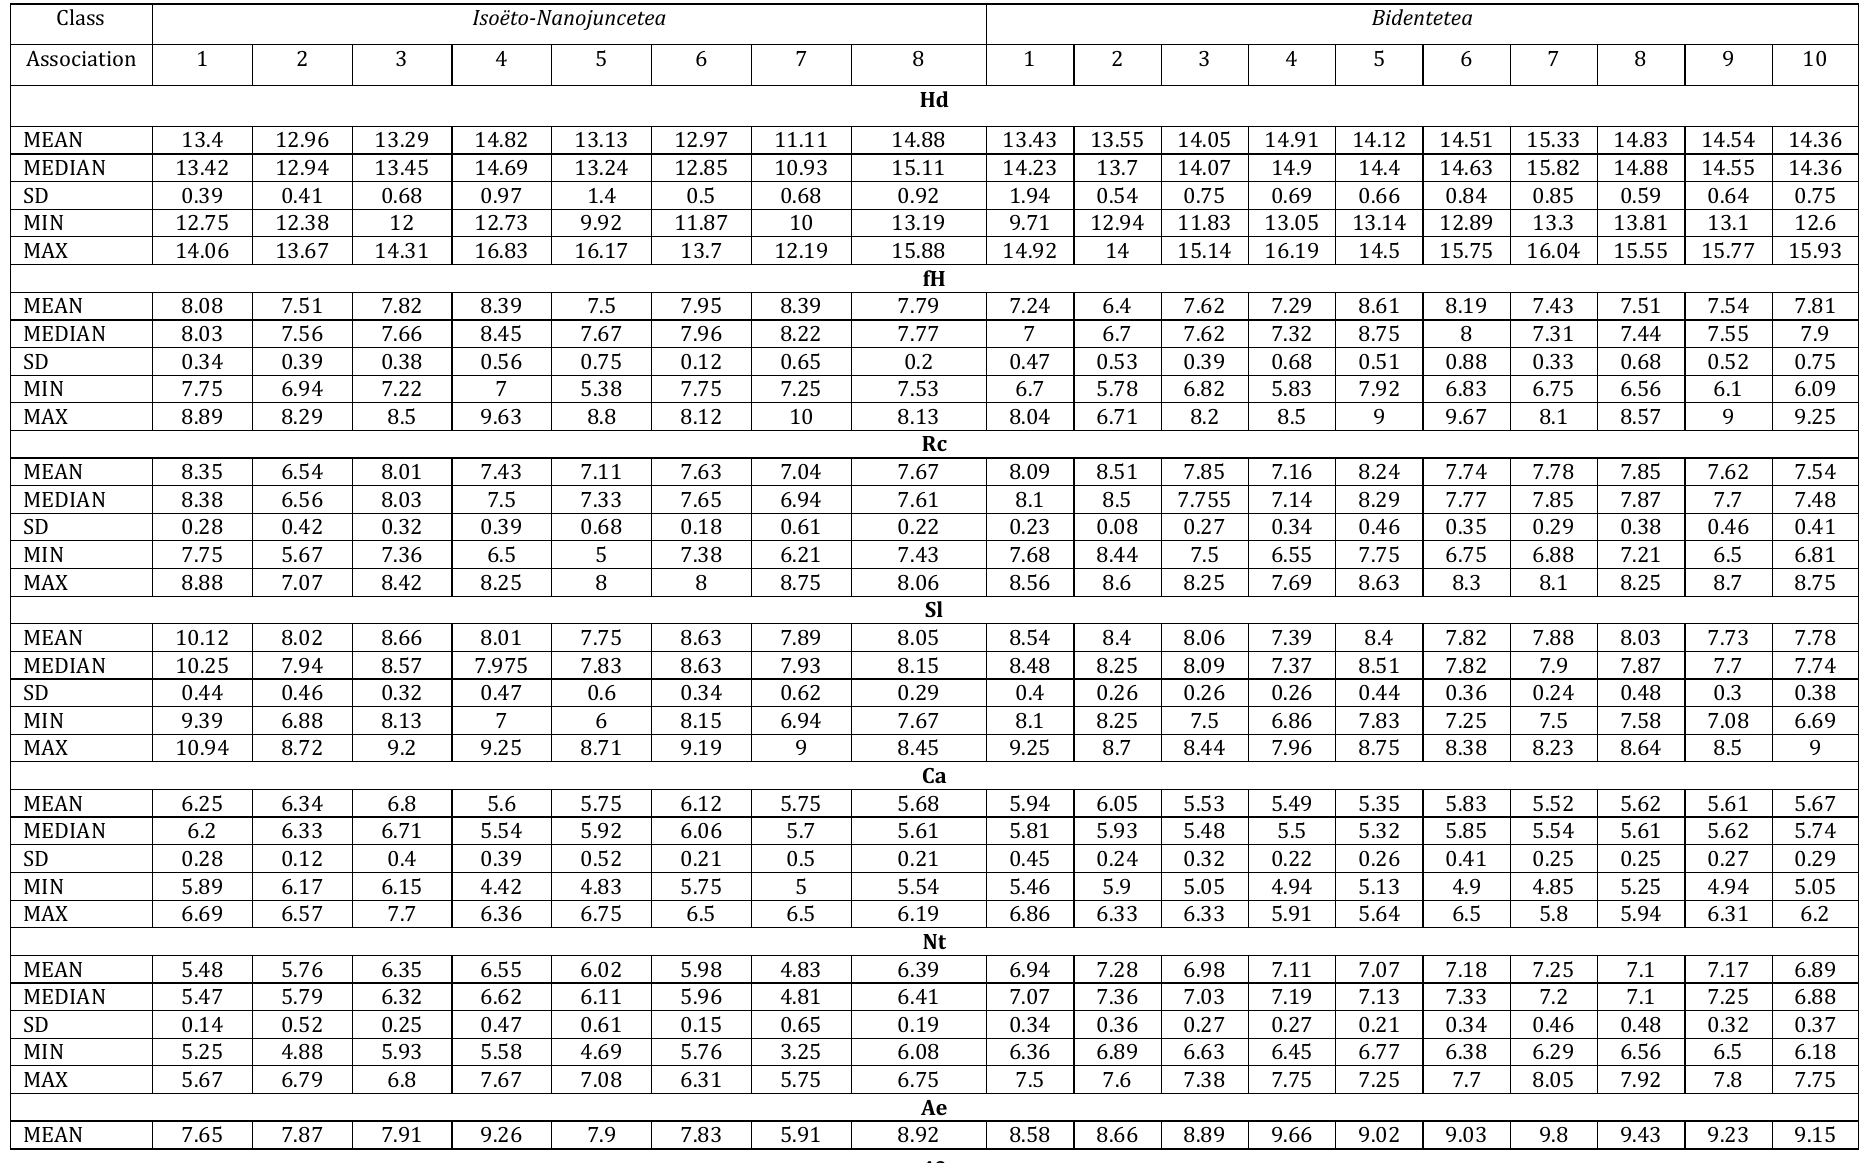
Table 2. Mean, median, standard deviation and extremes of ecological factors values (in points of phytoindication scale) for each